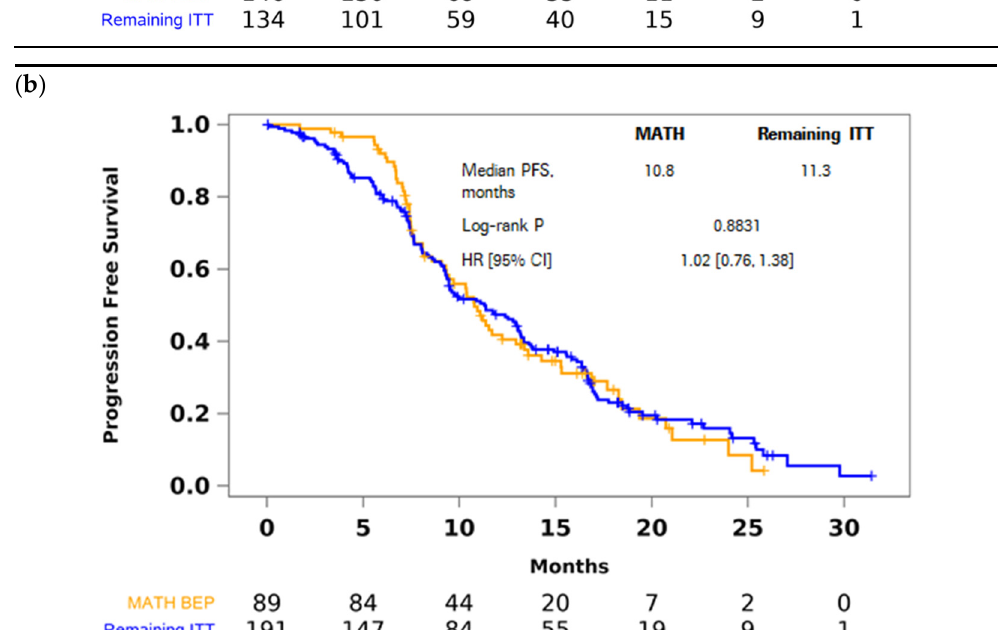
Figure A2. Comparison of PFS with remaining ITT population. ( a ) pre-induction comparison; ( b ), post-induction comparison.